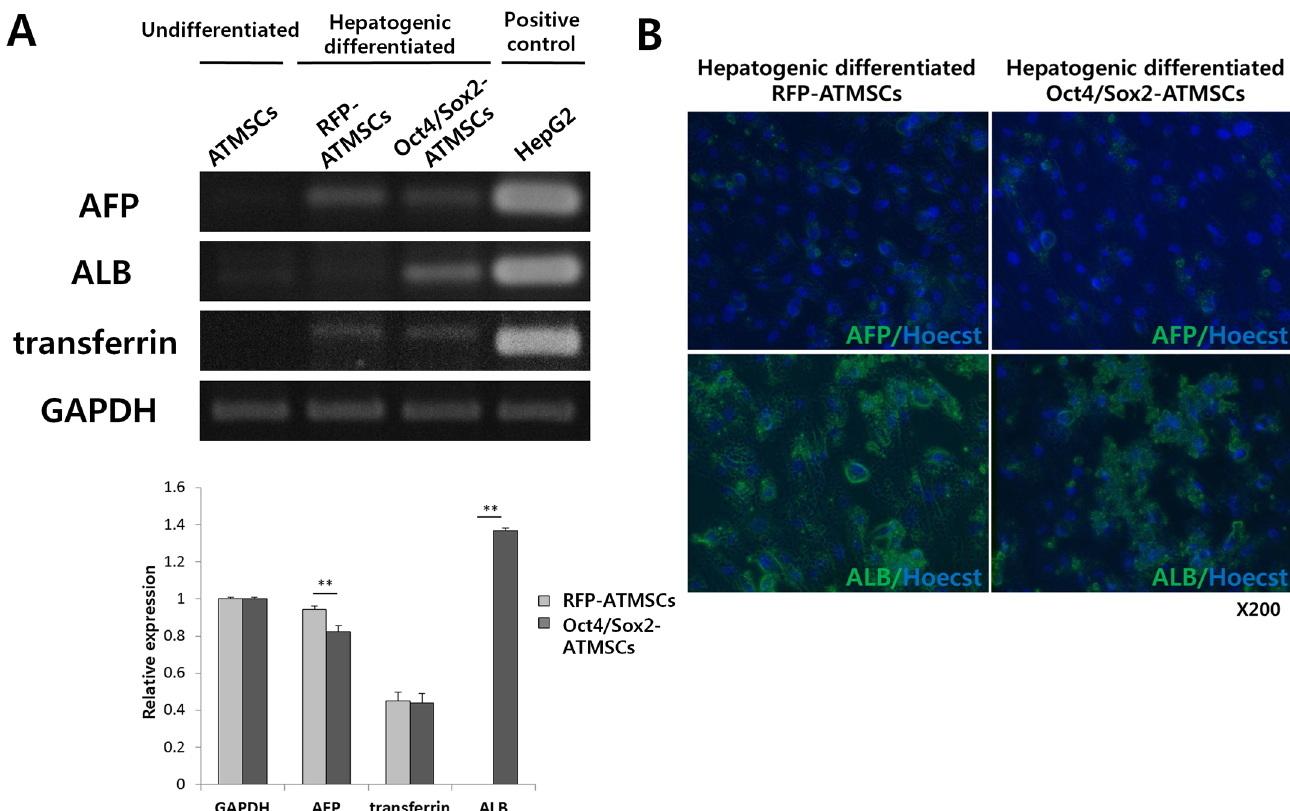
Fig 4. PCR analysis and immunofluorescenceof liver markers after 28 days hepatogenic differentiation. (A) The mRNA expressionlevel of albumin(ALB) was strongly expressedin hepatogenically differentiated Oct4/Sox2-ATMSCs, whereasthe expressionlevel of α -fetoprotein(AFP) was lower than that of RFP-ATMSCs. The expressionlevels of transferrin were not significantly different in both cells. Undifferentiated ATMSCs and HepG2 were used as negativeand positive controls, respectively.(B) Hepatocyte-like cells from RFP- and Oct4/Sox2-ATMSCs are confirmedby immunofluorescencestaining for AFP and ALB. Nuclei were counterstained with Hoecst33342.